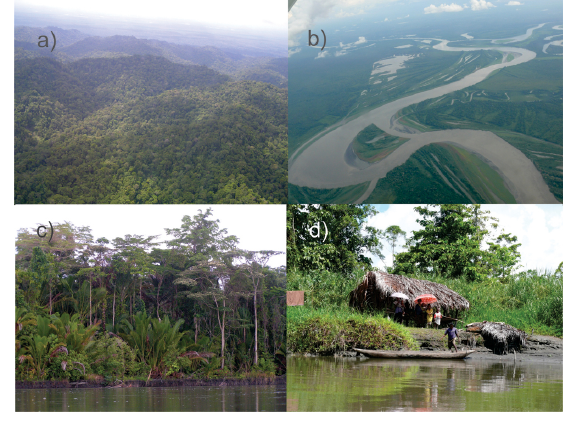
Fig. 2 . Typical land cover and features in the Mamberamo region. (a) Foothills of the Foja Mountains (DS); (b) dynamic flood plains with shifting rivers (MB); (c) mixed forest with sago palms (DS); (d) typical riverside huts near Kay